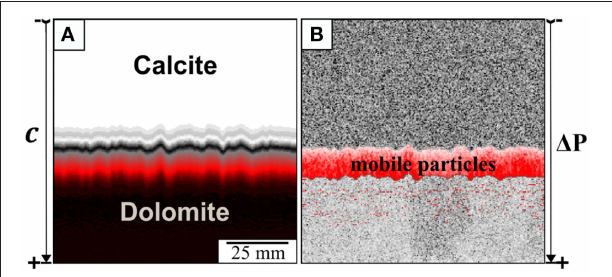
FIGURE 4 | Simulated reaction front after 2500 time steps. (A) Concentration ( c ) of Mg 2 + . The Bottom part is already dolomitized (black) and the grain growth process could already start. Different layers of concentration change are visible and these different bands of Mg 2 + could be interpreted as metastable phase in the transition from pure calcite to dolomite. The fluid flow follows the initially set pressure gradient ( 1 P ). (B) The advancing dolomitization front collects second-phase material along its propagation direction. The amount of captured particles depends on the size of the particles and the concentration change in the front between two time steps. The mobile particles (red) are moving together with the advancing front and represent the amount of second-phase material which is released from the crystal lattices by the dolomitization